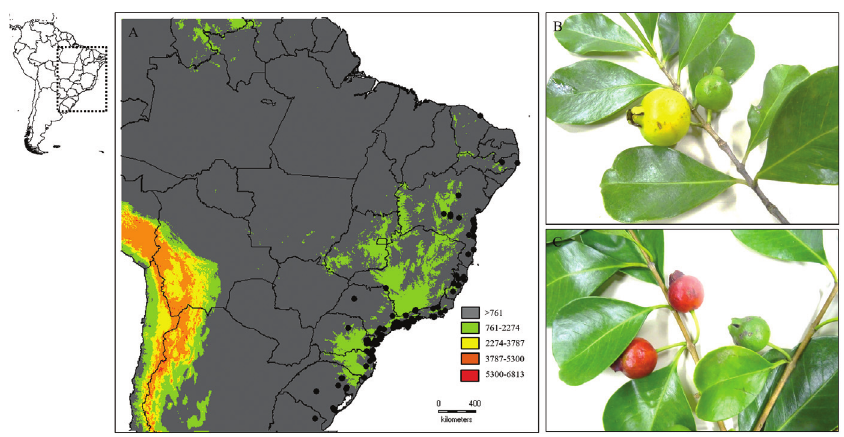
Figure 1 - Geographic distribution of P. cattleyanum and the morphological differences in their fruits. Map showing the natural distribution of P. cattleyanum in the Atlantic Forest (A). Data retrieved from the Global Biodiversity Information Facility - GBIF.org (08 May 2018) GBIF Occurrence Download https://doi.org/10.15468/dl.b6rsb0 and SpeciesLink (http://splink.cria.org.br/). Fruits of the yellow (B) and red (C) morphotypes of